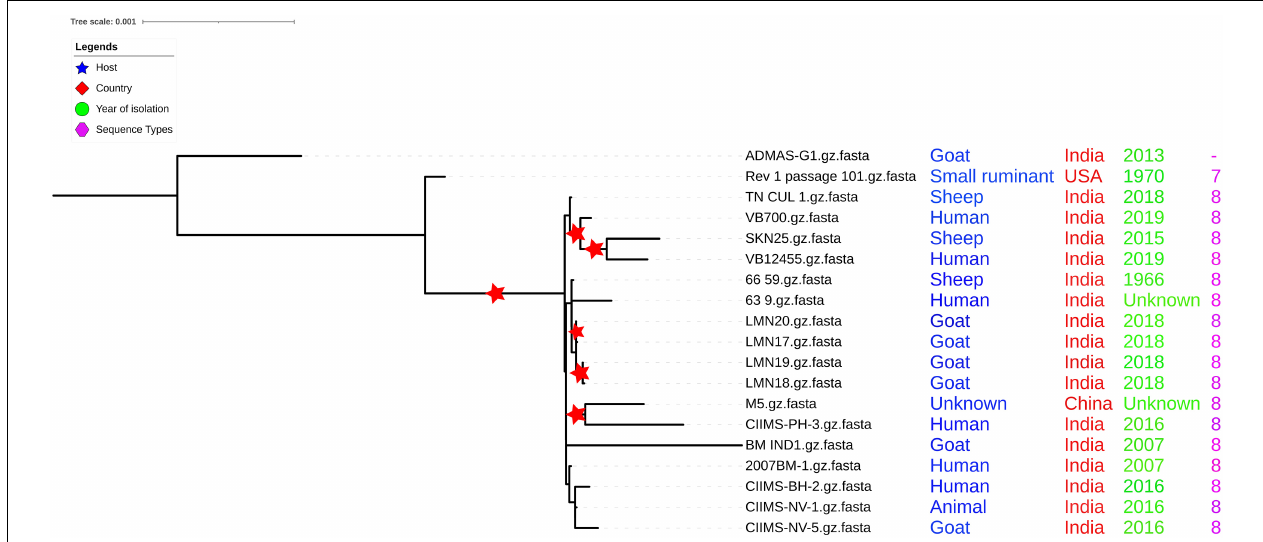
FIGURE 6 | Core genome phylogeny with multilocus sequence typing (MLST) profiling. All Indian strains belong to ST8 except ADMAS-G1. Two subclusters were found in core genome phylogeny.